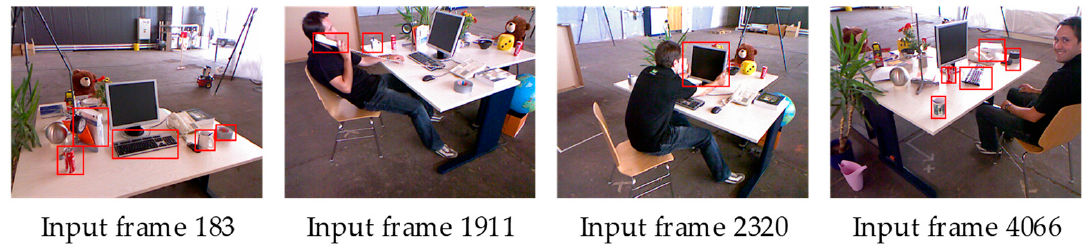
Figure 3. RGB frames from the TUM dataset containing dynamics.